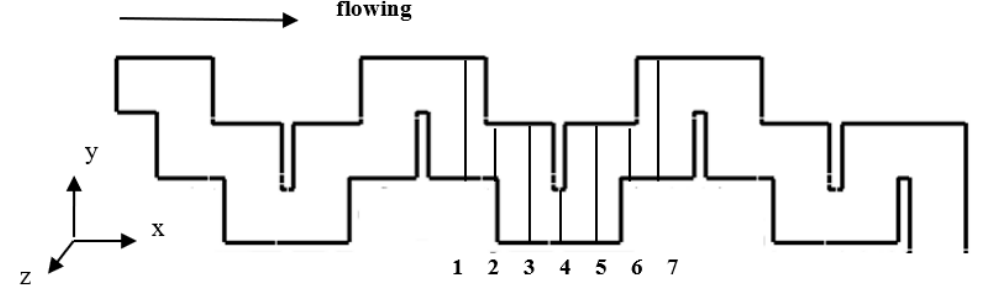
Figure 6. Schematic diagram of the longitudinal section of the flow path unit